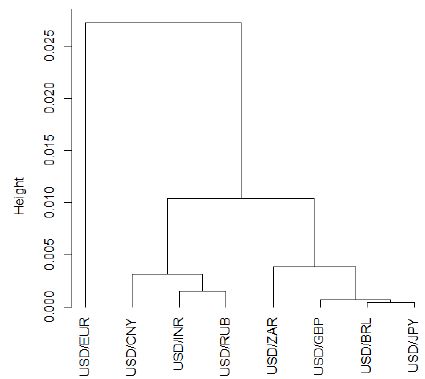
Figure A4. Dendrogram for the hierarchical cluster analysis for the eight currency, obtained using the “TSclust” package [56] of the R